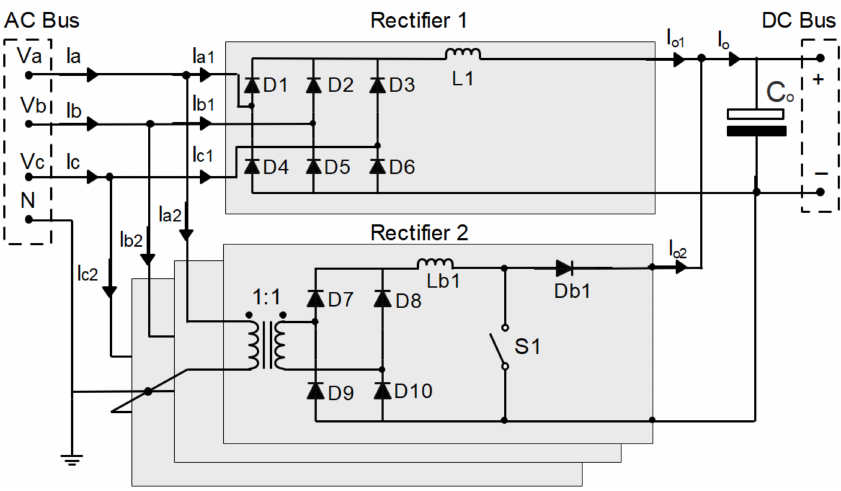
Figure 17. Configuration of the electrical circuit of the UHTR-R1//BR2.